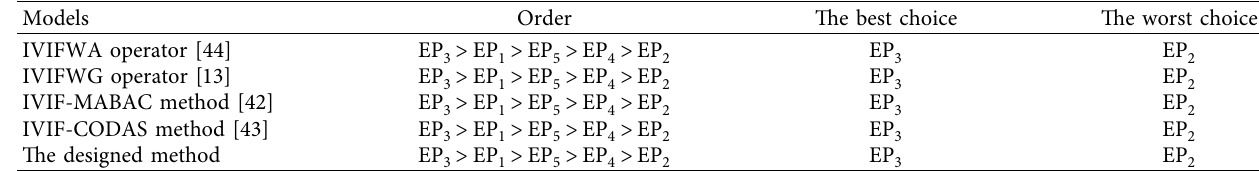
Table 13: The obtained results of other